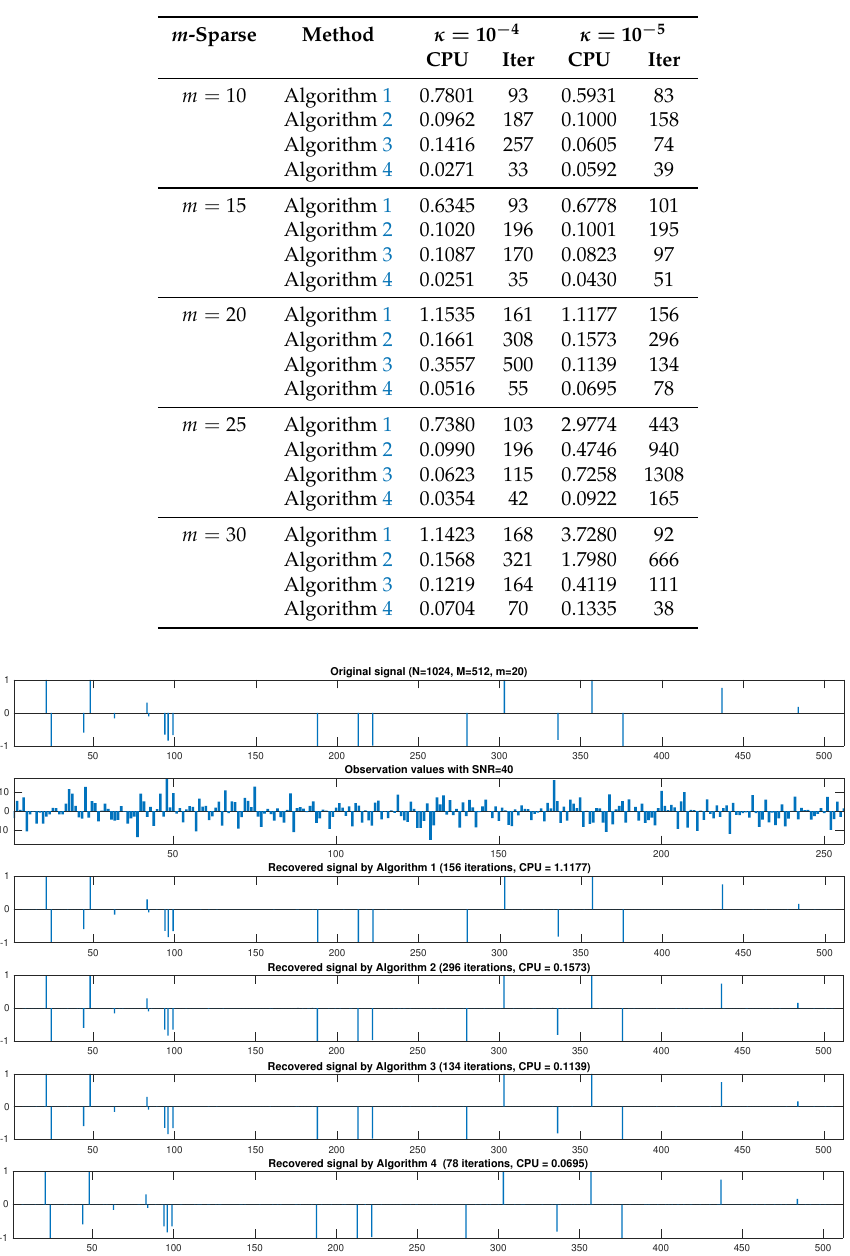
Table 1. Numerical results ( M = 512 and N = 1024).